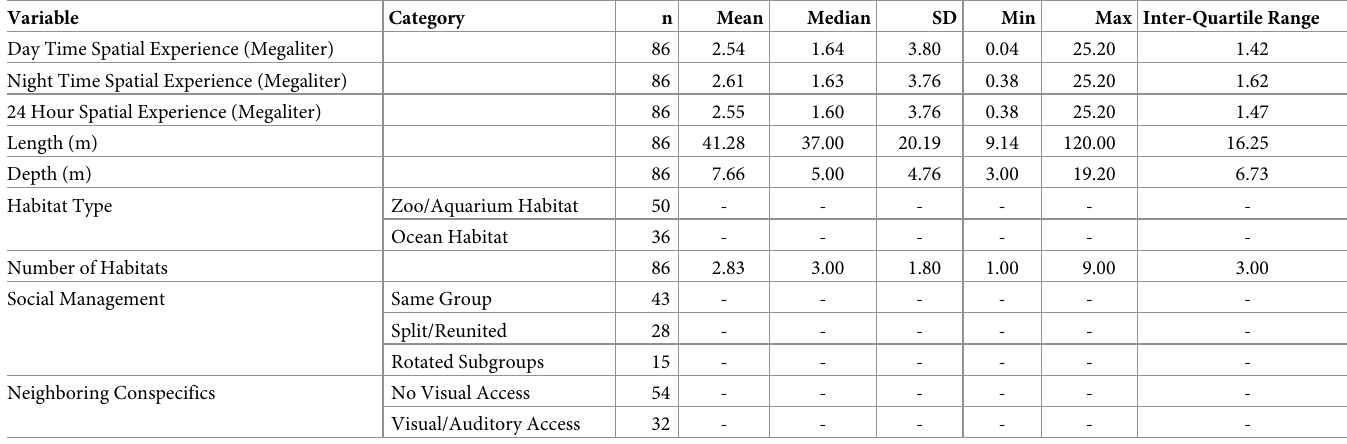
Table 5. Habitat characteristic